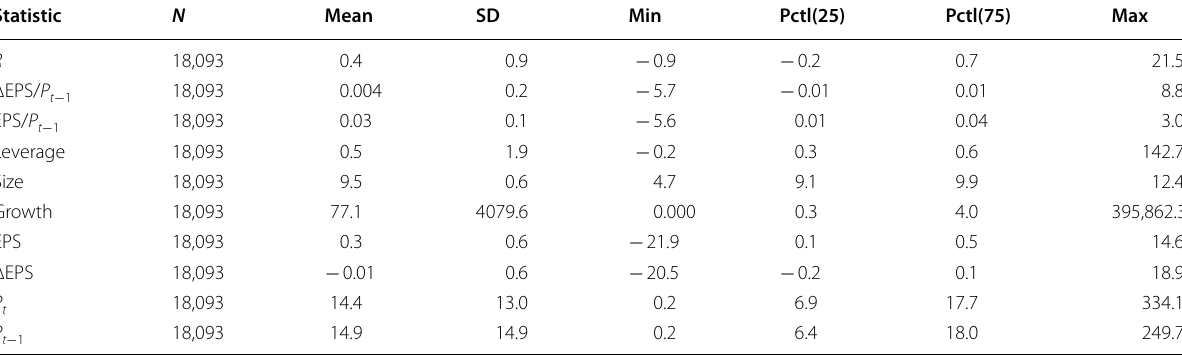
Table 5 Descriptive statistics using control